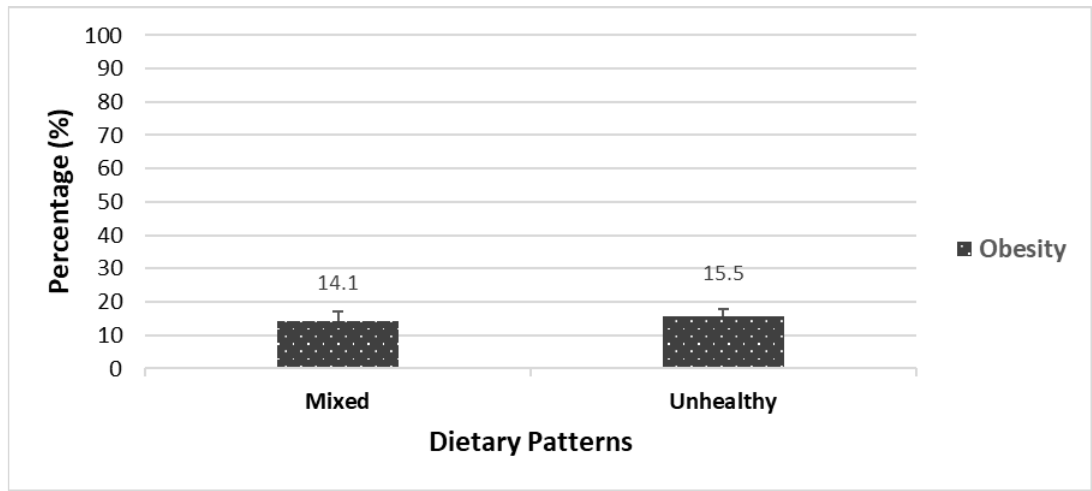
Figure 2. Prevalence of obesity across dietary patterns among Indigenous adults in